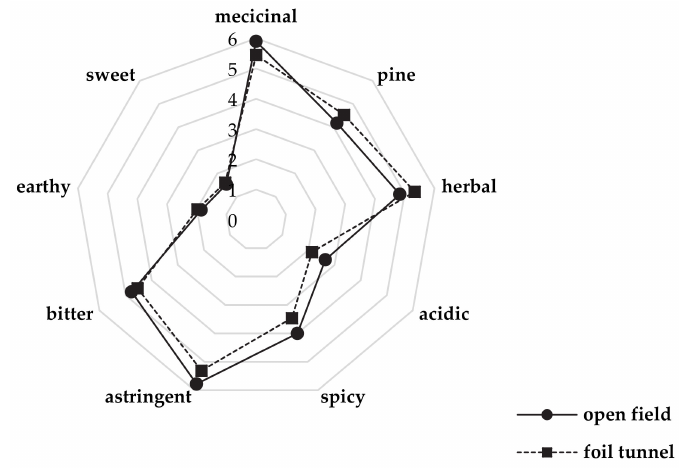
Figure 6. Sensory profile of common thyme herb